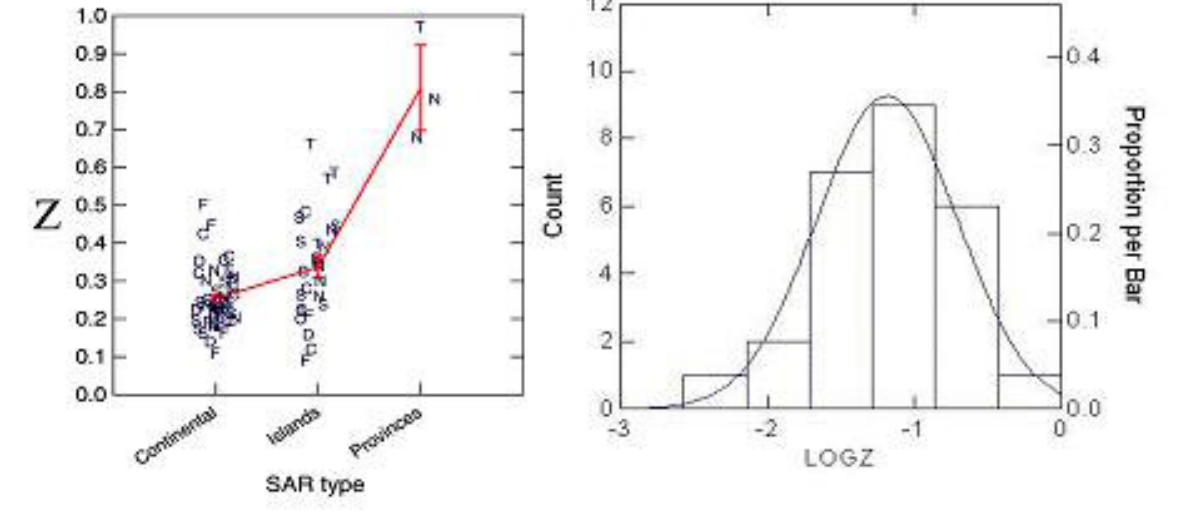
Fig. 2. Z values reported in studies on the species-area relationship in vascular plants. The points in the left panel correspond to individual studies and are labelled with the biome category of the area studied: T: tropical forest and tropical woodland; F: temperate deciduous forest, C: boreal forest, coniferous forest, wooded tundra and tundra; S: warm mixed forest, shrubland and savannah; D: grassland and desert; N: no specific biome. The red line joins up the means in each type; the error bars represent standard errors. The right panel shows the histogram of z -values of the species-area relationship in island studies of vascular plants, both oceanic islands and habitat fragments in mainland, fitted with a lognormal distribution. Source Sala et al. (2006). Copyright (c) 2005 Millennium Ecosystem Assessment. Reproduced by permission of Island Press, Washington,